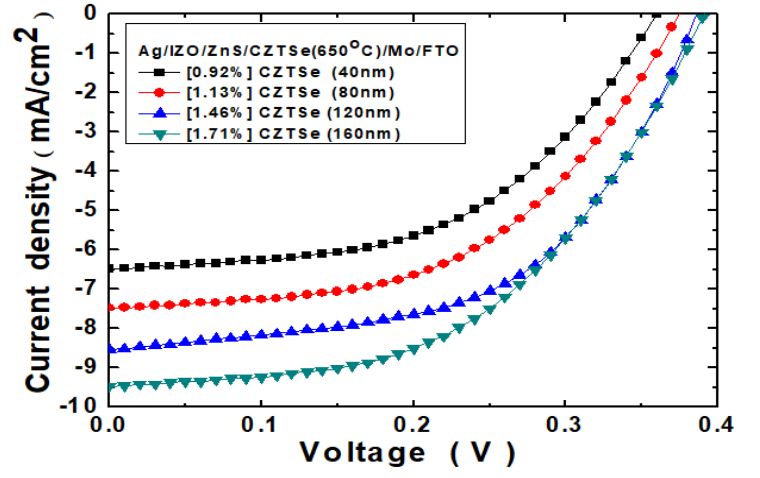
Figure 8. The J – V curves of Ag / IZO / ZnS / Cu 2 ZnSnSe 4 / Mo / FTO nanostructured solar cells, under 100 mW / cm 2 illumination. The Cu 2 ZnSnSe 4 HTM layer thickness has been varied at 40–160 nm. Table 1. The PV characteristic parameters of the Ag / IZO / ZnS / Cu 2 ZnSnSe 4 / Mo / FTO nanostructured solar cells.